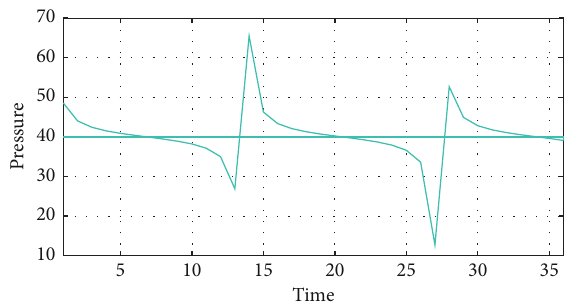
Figure 3: Hydrodynamic simulation (1).